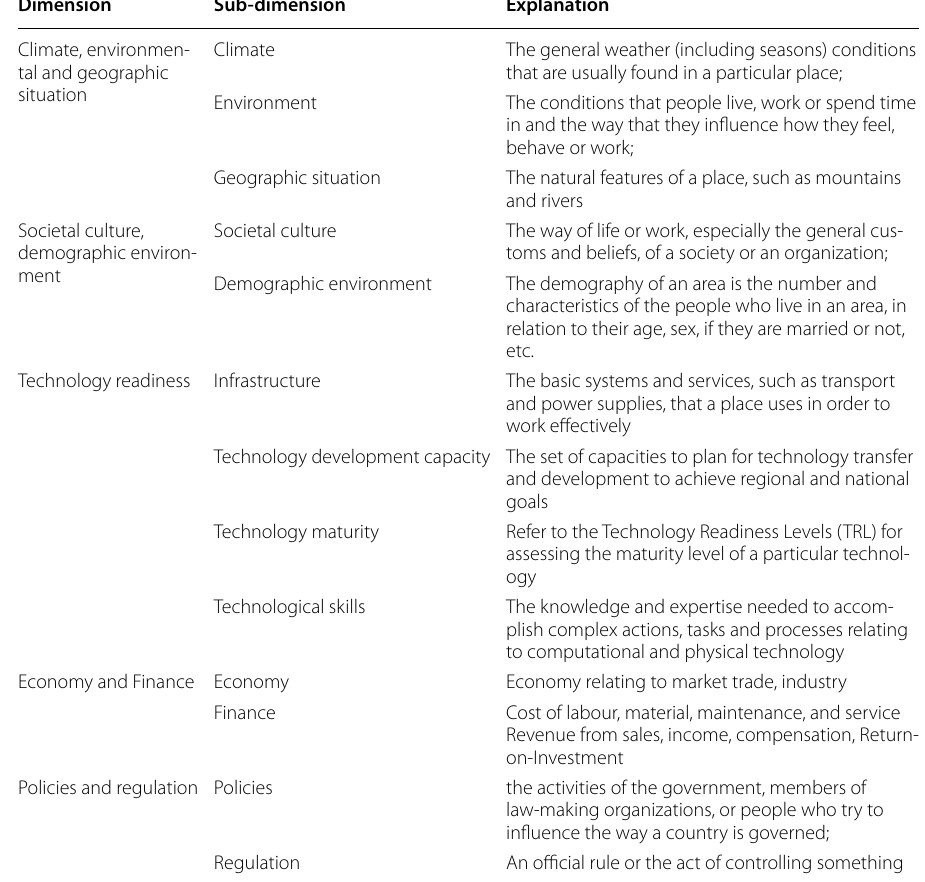
Table 6 Definitions of CSTEP five dimensions (Ma 2022) Dimension Sub-dimension Explanation Climate, environmen- tal and geographic situation